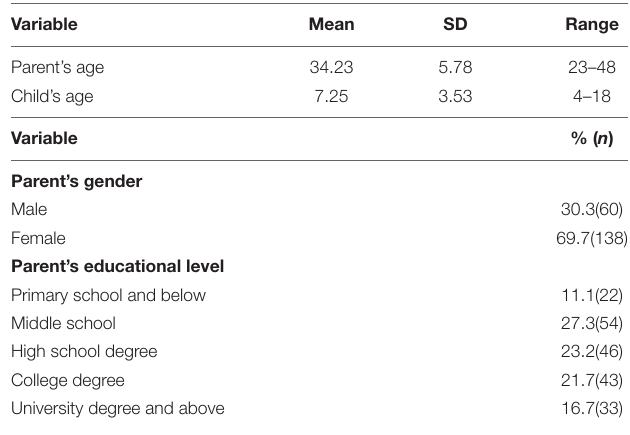
TABLE 1 | Demographic characteristics of